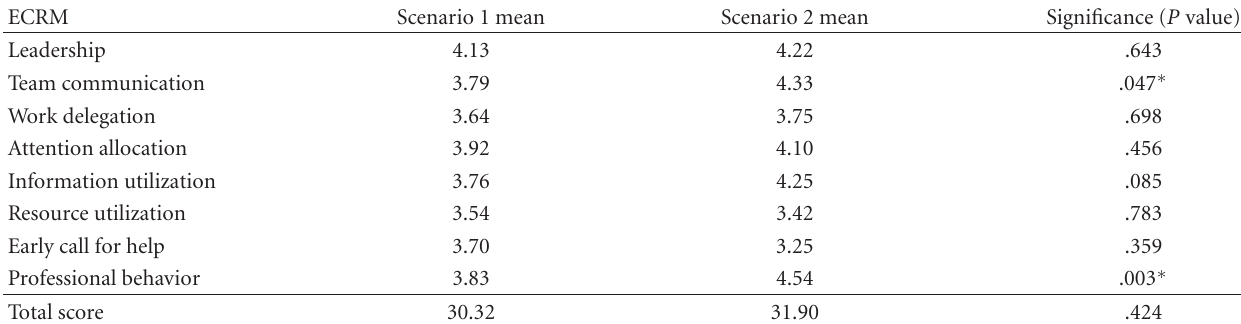
Table 2: Results comparing scenario 1 (time 1) to scenario 2 (time